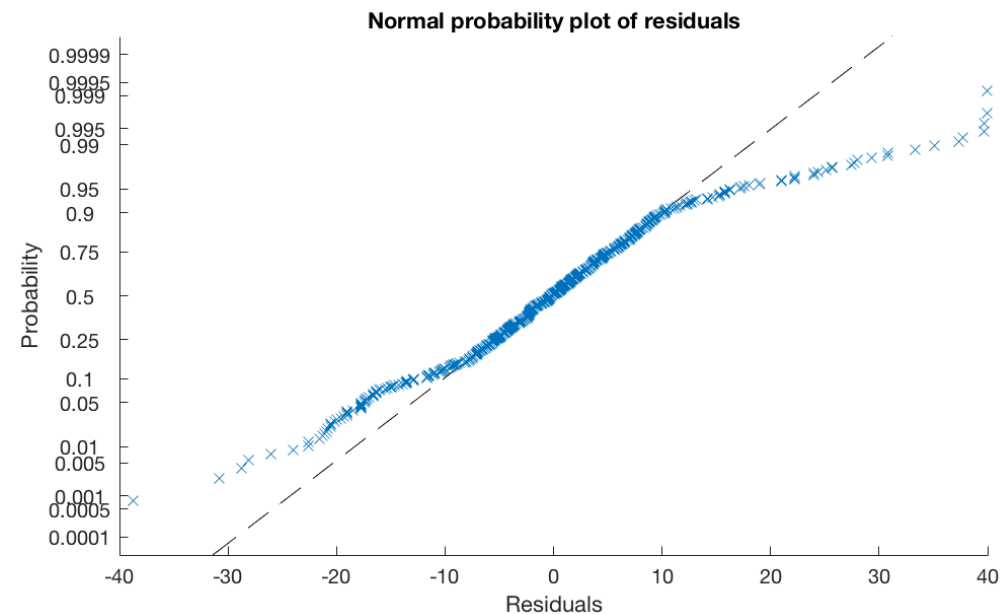
Figure 5. Normal probability plot of residuals illustrating a linear relationship and reinforcing the normal distribution assumption.